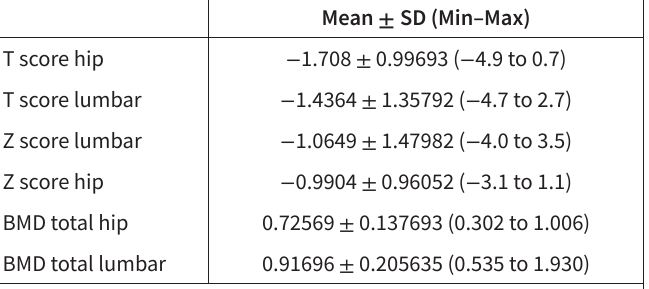
Table 1. Descriptive Statistics of BMD Scores According to NHANES